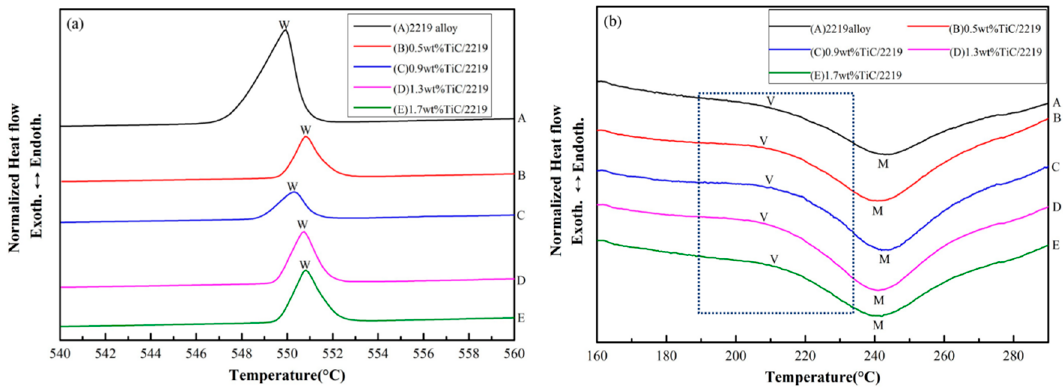
Figure 7. DSC heating curves of the forged and heat-treated TiC / 2219 nanocomposite samples: ( a ) endothermic peak W represents the dissolution of phases, and ( b ) exothermic peak M represents the precipitation and growth of the precipitated phases.